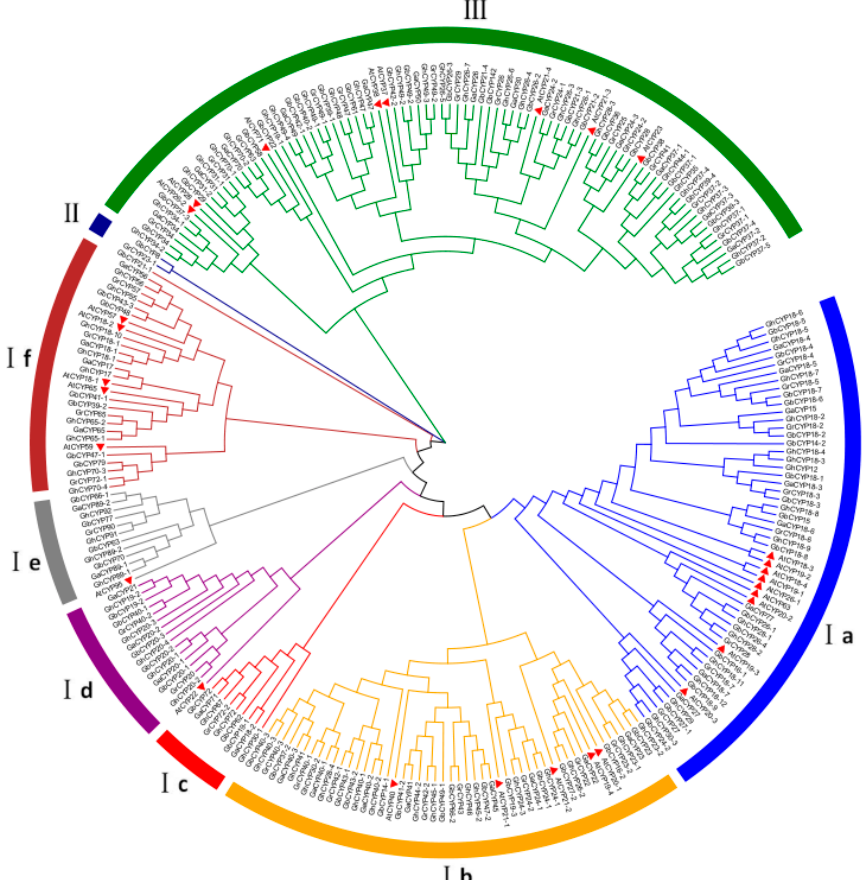
Figure 1. Phylogenetic tree of 260 cyclophilin (CYP) proteins from G. barbadense (A-subgenome 42, D-subgenome 33), G. hirsutum (A-subgenome 41, D-subgenome 37), G. arboretum (40), G. raimondii (38) and Arabidopsis (29). MEGA 6.0 was used to build the neighbour-joining (NJ) tree with 1000 bootstrap replicates. Different line colours indicate different subgroups of CYPs. AtCYPs are represented by red triangles.